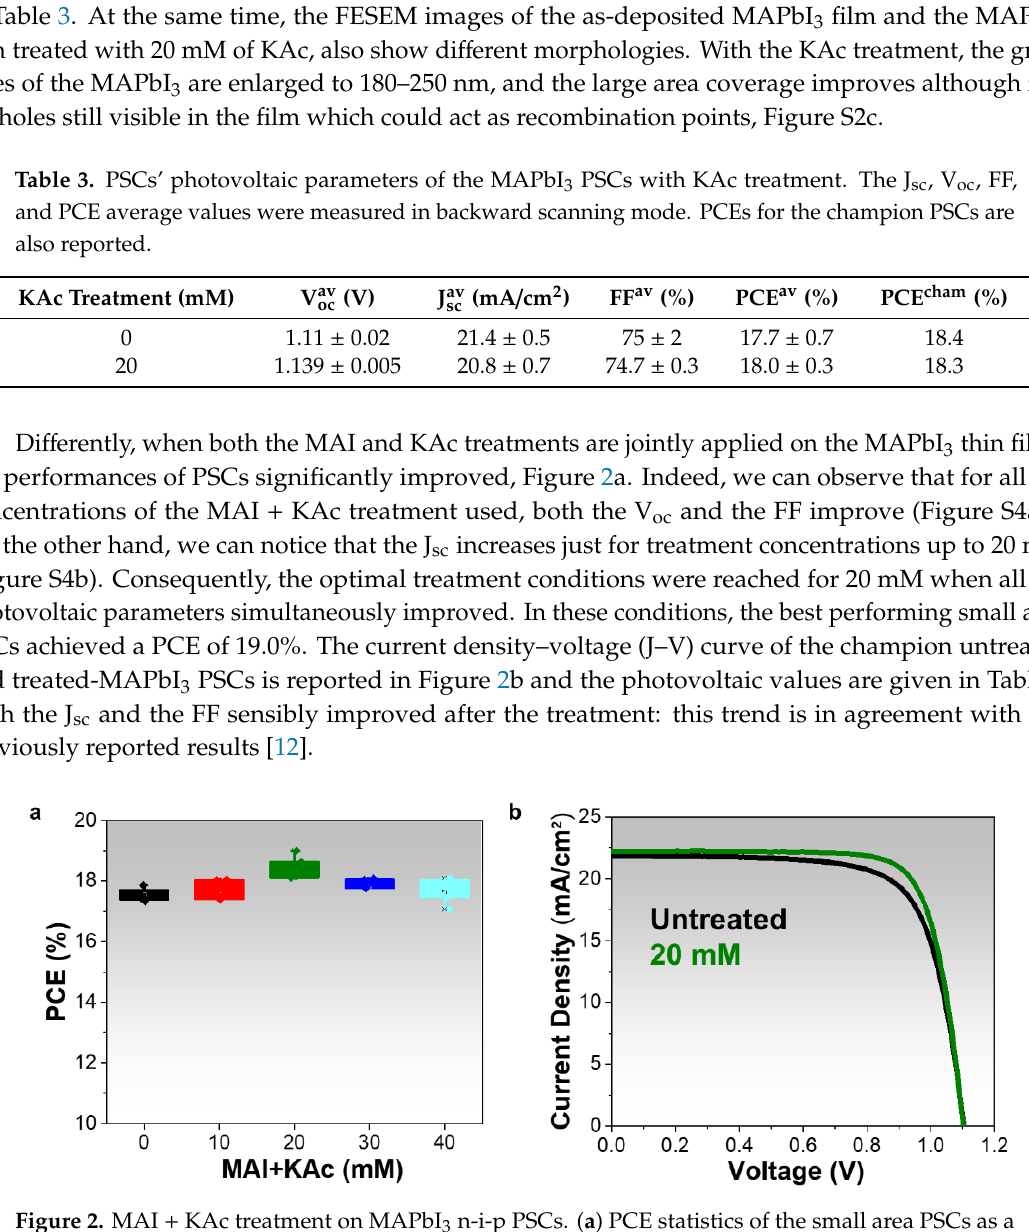
Figure 2. MAI + KAc treatment on MAPbI 3 n-i-p PSCs. ( a ) PCE statistics of the small area PSCs as a function of the MAI/KAc treatment concentration, and ( b ) current density–voltage (J–V) curves of the champion untreated and treated MAPbI 3 PSCs.